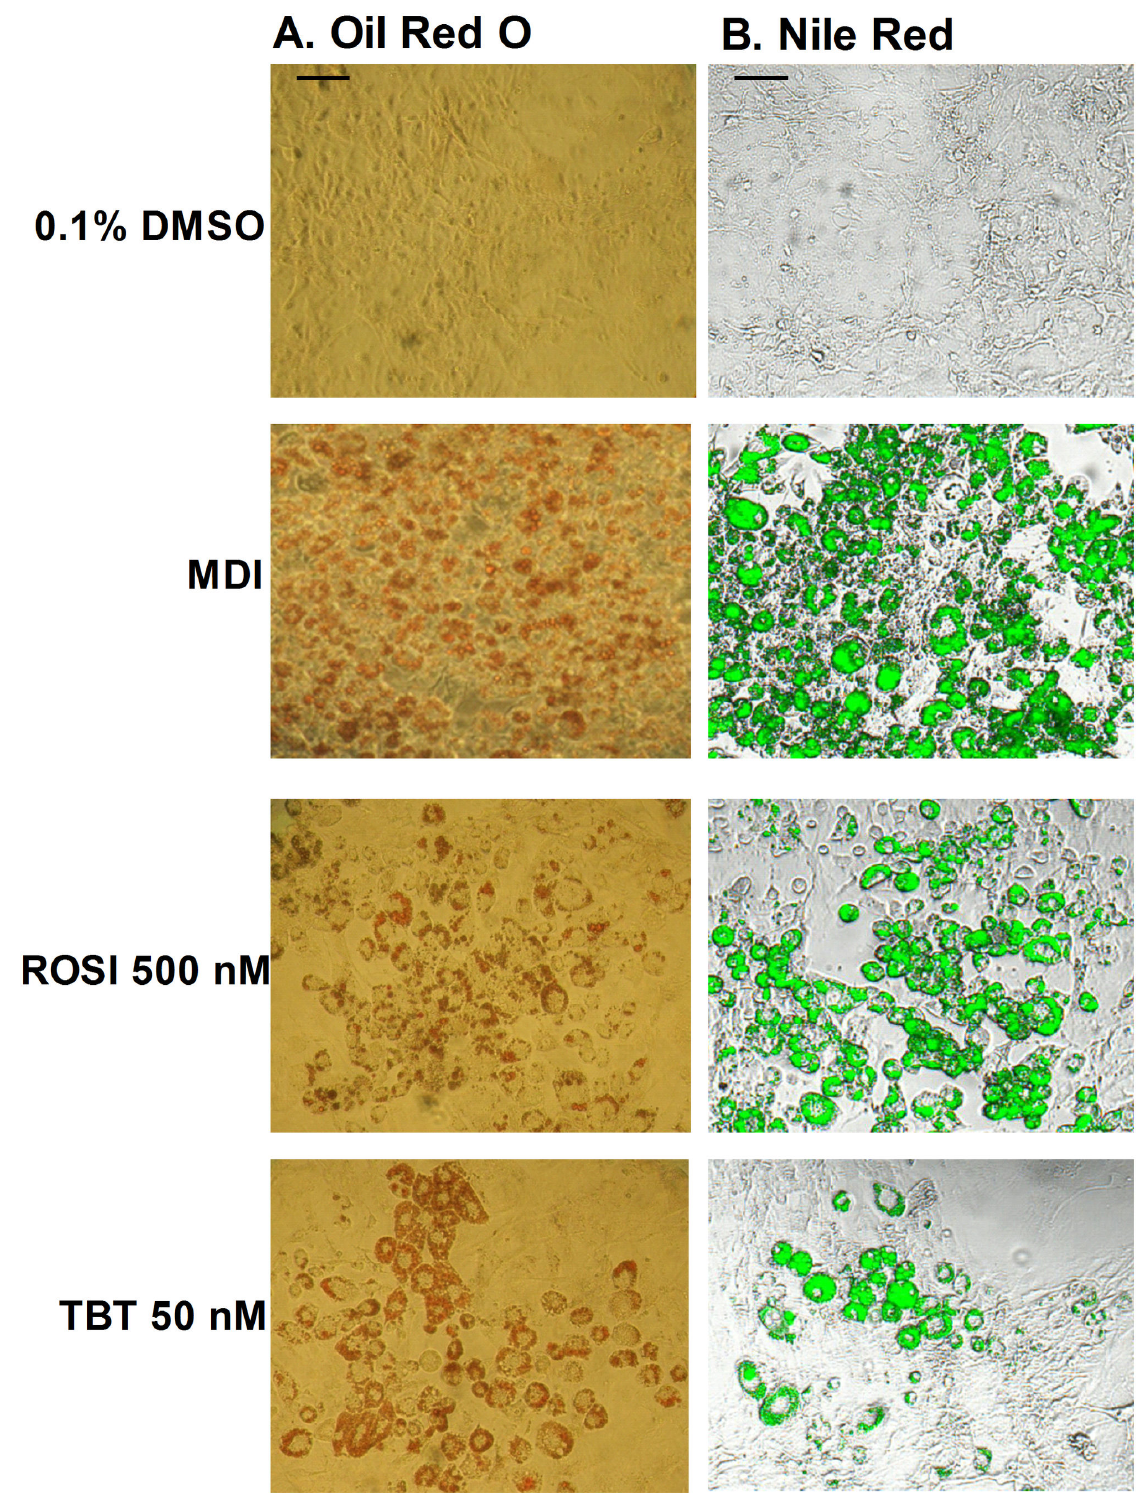
Figure 2. Pictures of Oil Red O and Nile Red stained 3T3-L1 cells after 10 days of exposure to reference compounds and solvent/positive control. Light microscopic pictures (A; Oil Red O staining) and fluorescent (b; Nile Red staining) were taken. Pictures were only taken for visualisation of the differentiation and not for quantification. Scale bar represents 50µm. doi: 10.1371/journal.pone.0077481.g002 PLOS ONE |